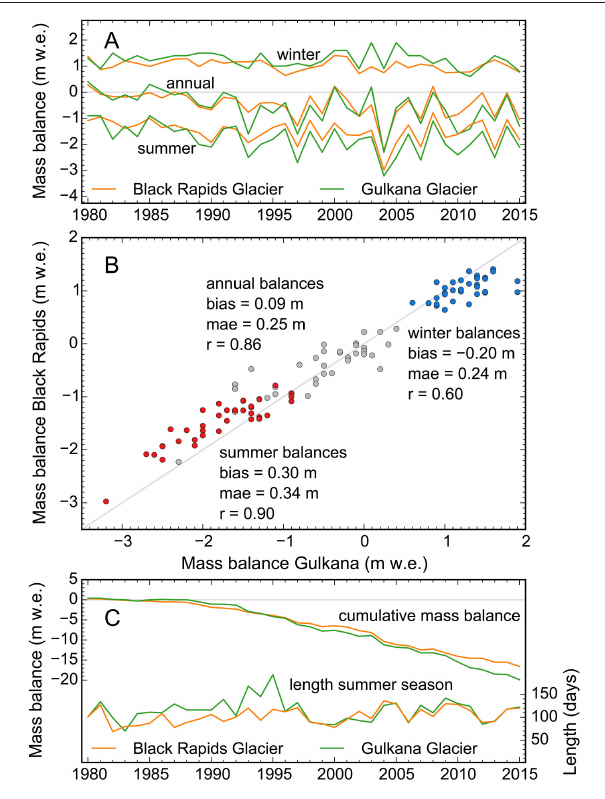
FIGURE 11 | (A) Glacier-wide specific mass balances for Black Rapids Glacier (orange, this study) and Gulkana Glacier (green, O’Neel et al., 2014) during the period 1980–2015. Both series reflect conventional balances (i.e., obtained with regularly updated glacier hypsometries/extents) in the stratigraphic time system (i.e., with annual mass balances reaching from one annual glacier-wide mass minimum to the next and winter (summer) balances reaching from the annual glacier-wide minimum (maximum) to the maximum (minimum)). (B) Specific mass balances of Gulkana Glacier vs. Black Rapids Glacier, with corresponding statistical parameters. (C) Cumulative series of the annual glacier-wide mass balances (left axis) and evolution of the summer season length (right